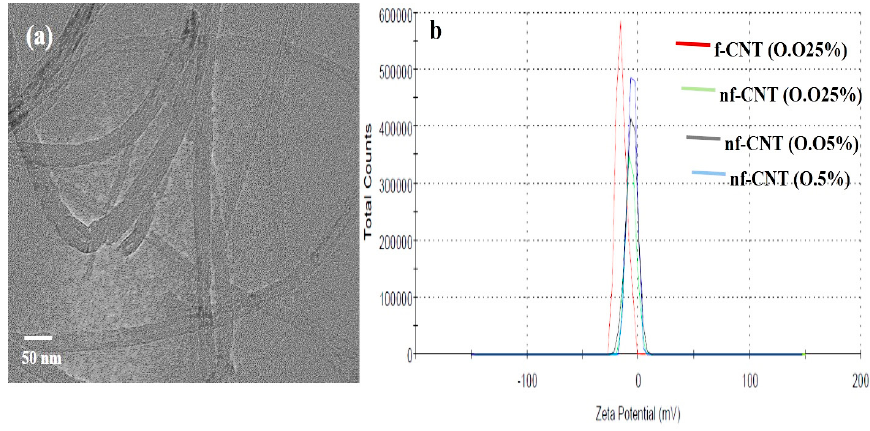
Figure 1. ( a ) Transmission electron microscopy (TEM) image of functionalized carbon nanotube (f-CNT); and ( b ) Zeta potential distribution curve of f-CNTs and non-functionalized CNTs (nf-CNTs).